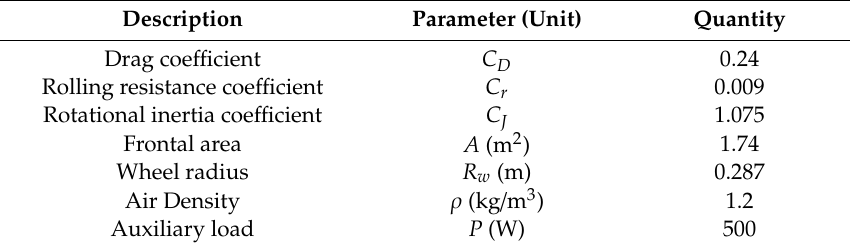
Table 1. Constant parameters for the vehicle dynamic